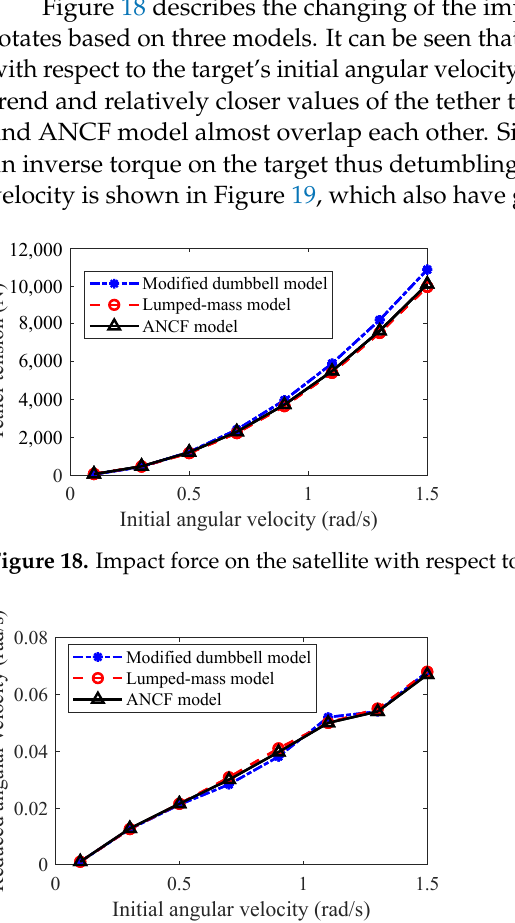
Figure 19. Reduced angular velocity with respect to the initial angular